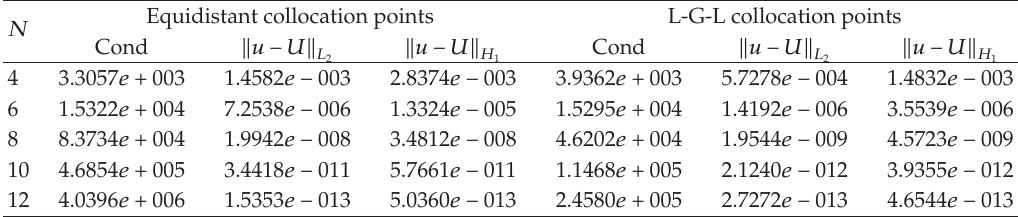
(cid:4) 100, β (cid:4) 10 (cid:6) 1 2